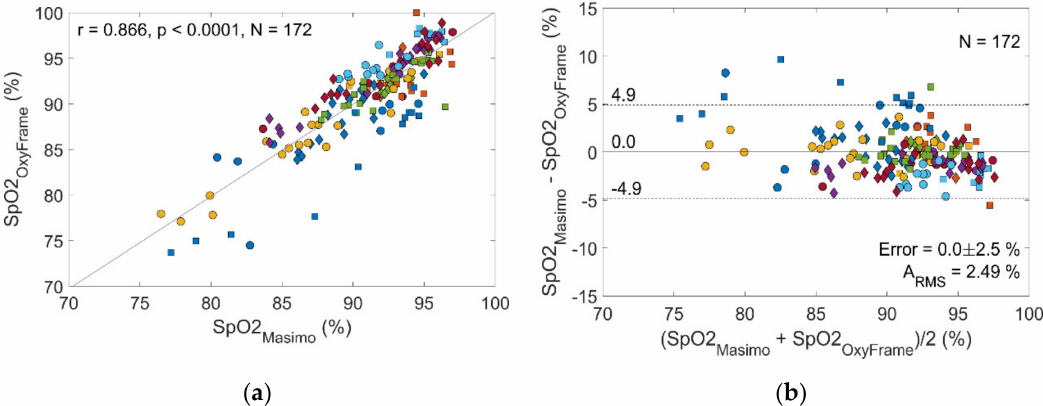
Figure 5. Performance of the OxyFrame device compared to a standard sensor (MASIMO) in patients. ( a ) Correlation plot S p O 2 measurement by OxyFrame versus MASIMO. ( b ) Bland-Altman plot S p O 2 measurement by OxyFrame versus MASIMO. Measurements of the same patient have the same color and